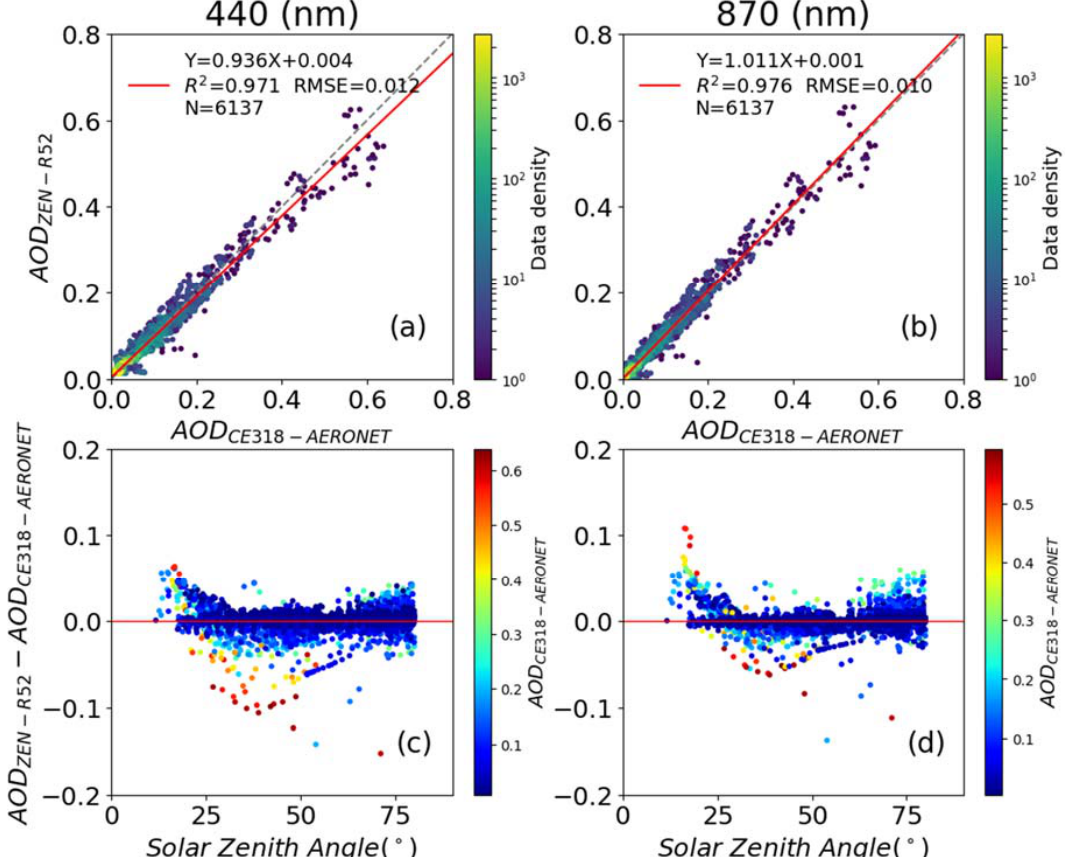
Figure 7. AOD scatter plot between AERONET and ZEN-R52 at 440 nm ( a ) and 870 nm ( b ) nominal wavelengths. The red line shows the linear fit equation, the broken grey line shows the diagonal and the colour bar indicates the density of data. ZEN-R52–AERONET AOD di ff erences against the solar zenith angle are shown in ( c ) for 440 nm and in ( d ) for 870 nm, where the colour bar indicates AERONET AOD.